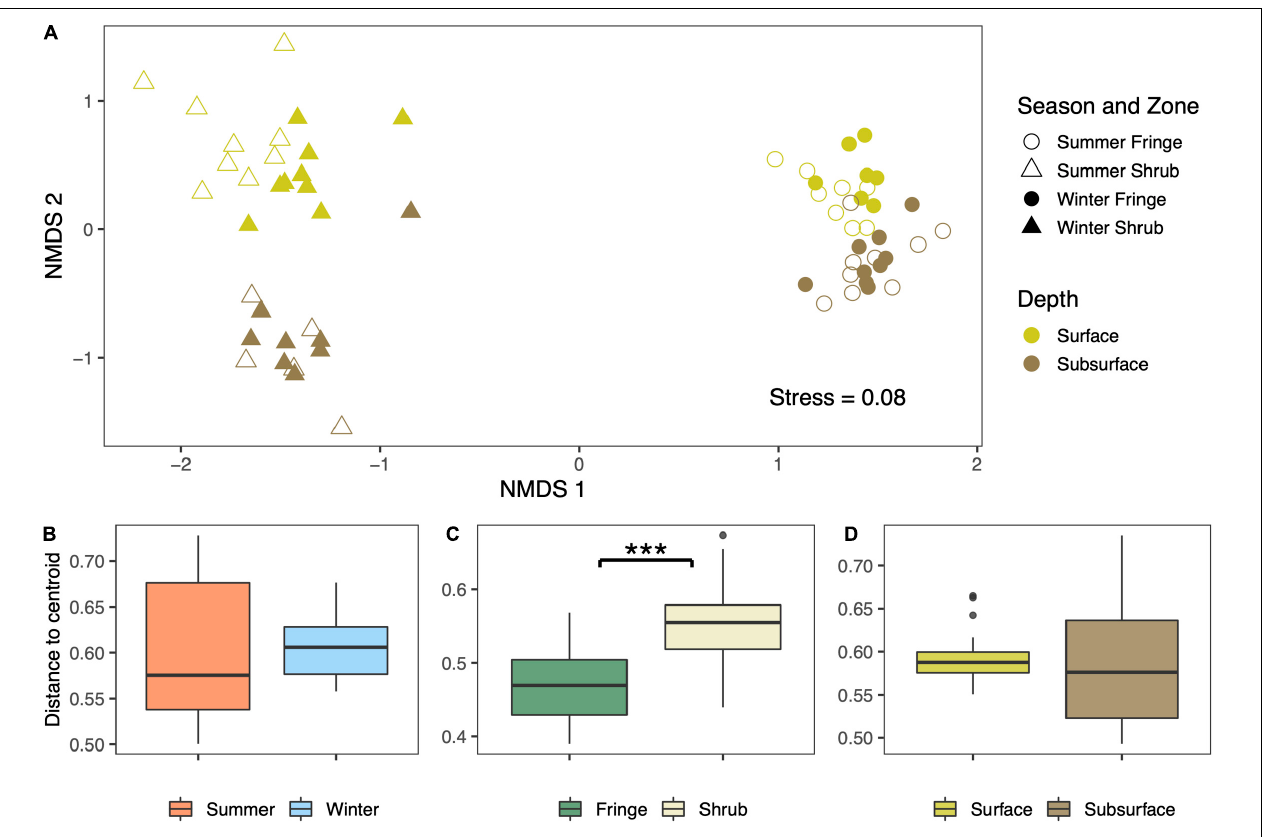
FIGURE 6 | (A) Non-metric multidimensional scaling (NMDS) plot based on Bray-Curtis distance shows high levels of separation between the samples by factors along the first and the second NMDS axis. The level of dispersion within the individual factors (B) season, (C) zone, and (D) depth was calculated as the mean distance of each sample point to the centroid of the respective factor. The three asterisks indicate a significant level of heterogeneous dispersal between the fringe and the shrub samples. The center line in the box displays the median and the margins of the box specify the 25th and 75th percentile. Whiskers extend to the smallest (lower whisker) or the largest (upper whisker) value within the range of 1.5 × interquartile range.